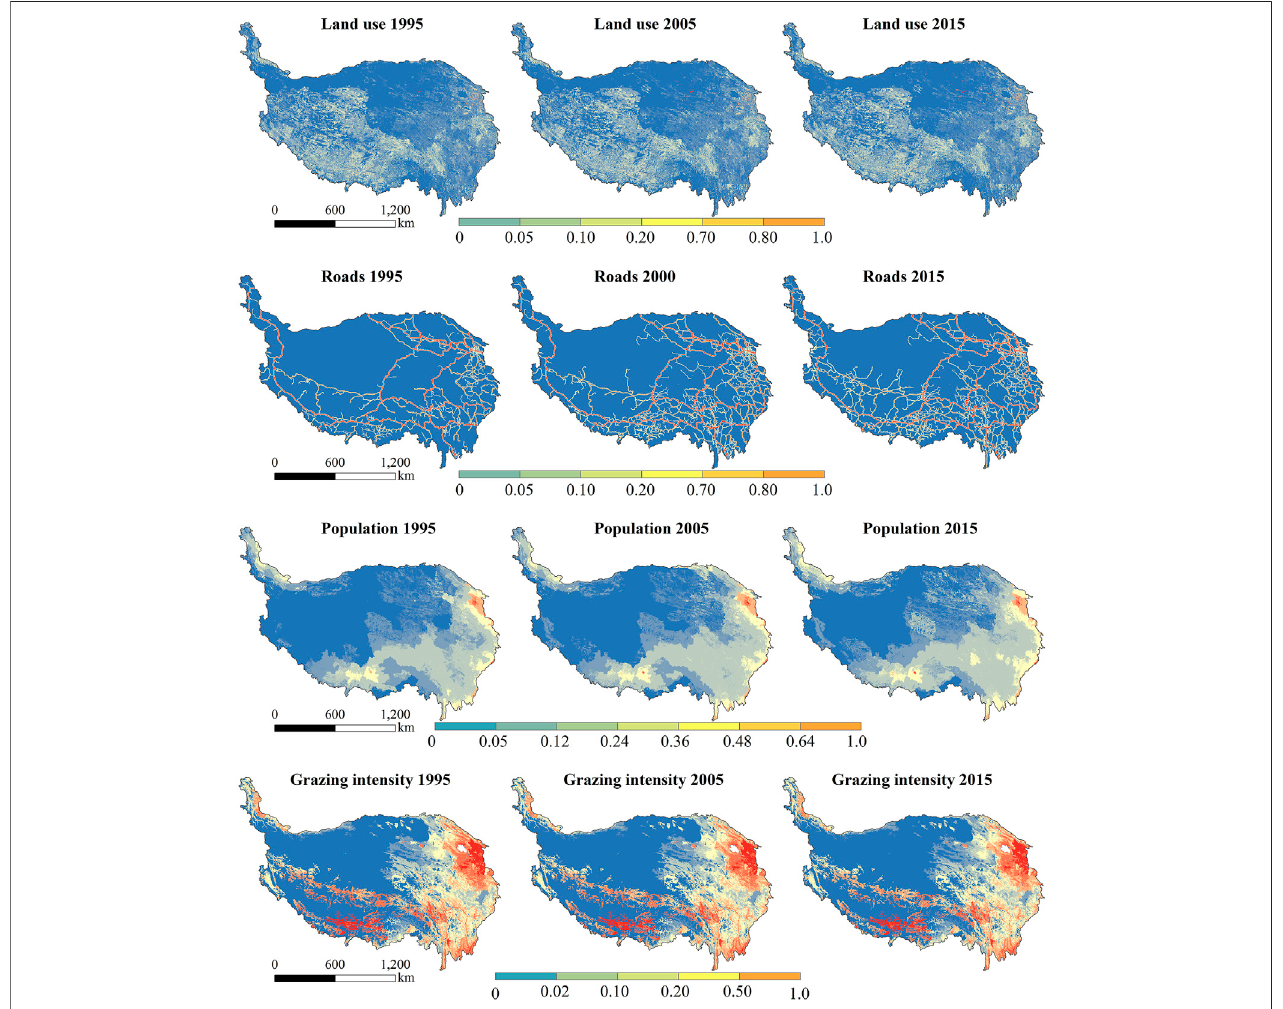
FIGURE 3 | Spatial distribution of four individual human activity intensity datasets in 1995, 2005, and 2015 on the Qinghai – Tibet Plateau.